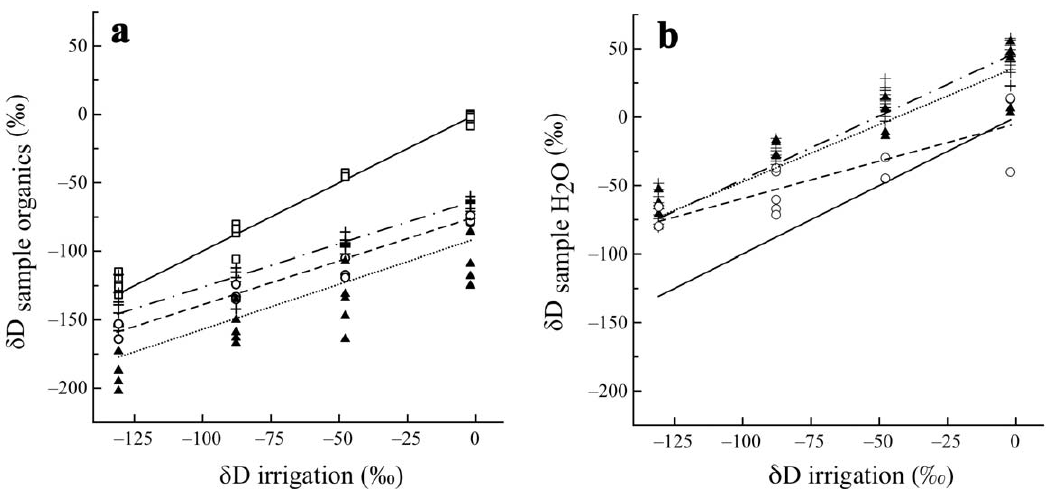
Figure 1. d D of organic matter and extracted water of plant and insect tissues are linearly correlated to d D of irrigation water. (a) The d D values of the organic matter of plants (solid triangles, dotted line), caterpillars (plus ‘ + ’ signs, barred-dotted line), and moths (open circles, barred line) increased linearly with the d D value of irrigation water (y plant =0.59x 2 107.5, r 2 =0.74; y caterpillar =0.59x 2 81.2, r 2 =0.90; y moth =0.59x 2 67.8, r 2 =0.90). These relationships had a common slope that was significantly less than 1. Note that the d D value of soil (open squares) did not differ from that of irrigation water (y=x, solid line). Plant, caterpillar, and moth tissues are significantly depleted in deuterium relative to irrigation water. (b) The d D value of water extracted from plants (solid triangles, dotted line), caterpillars (plus ‘ + ’ signs, barred-dotted line), and moths (open circles, barred line) was also linearly related to that of irrigation water (y plants H2O =0.73x + 34.7, r 2 =0.86; y caterpillar H2O =0.85x + 46.8, r 2 =0.94; y moth H2O =0.41x 2 19.2, r 2 =0.44). Extracted water samples from plants, caterpillars and moths were enriched in deuterium relative to irrigation water. The slope of the relationships of the d D value of irrigation water to water extracted from plants and caterpillars did not differ significantly. The slope of the relationship between the d D value of irrigation and that of water extracted from moths was significantly shallower.